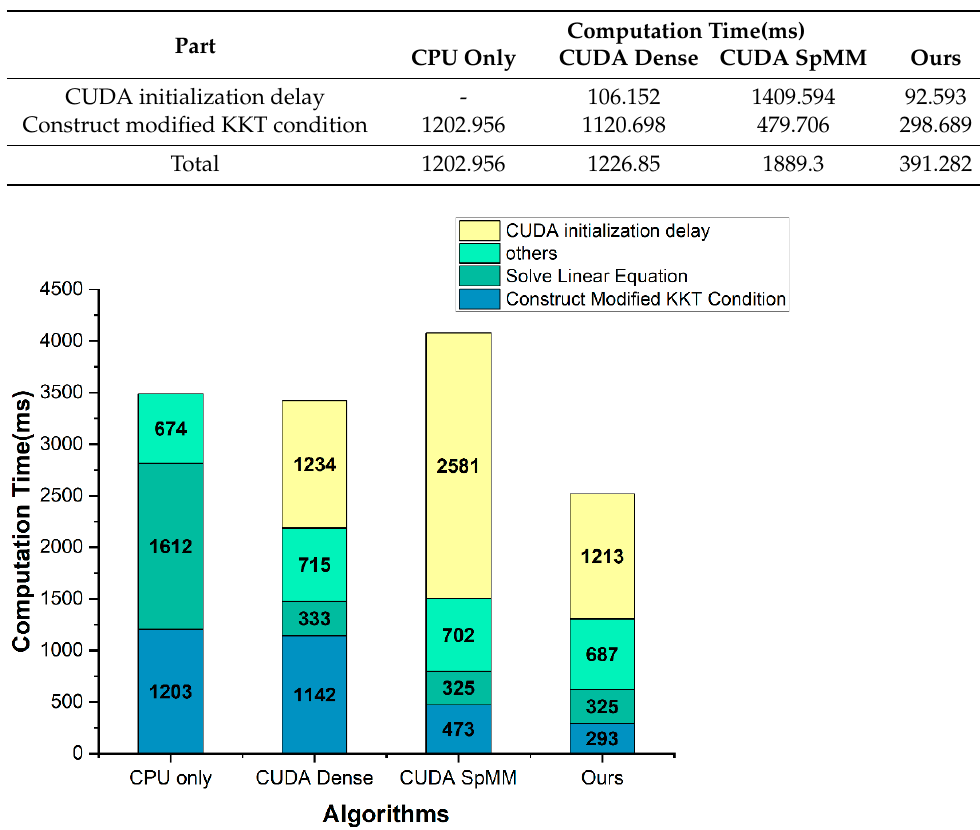
Figure 6. The computation time comparison result graph of the entire